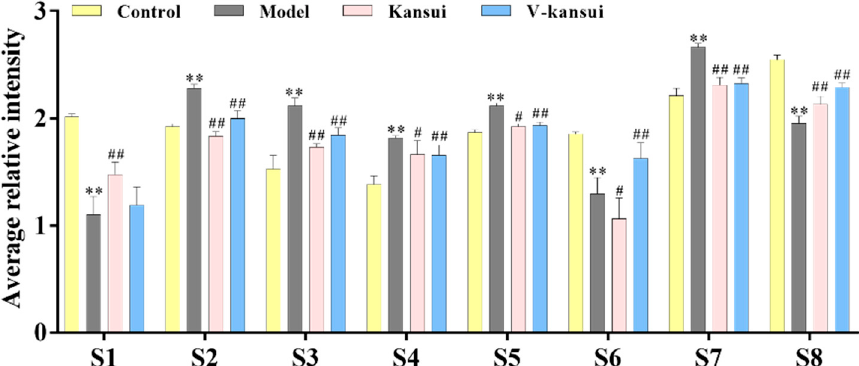
Figure 2. The average relative intensity changes of serum endogenous metabolites from different groups. Comparing the model group with the control group, ** indicates p < 0.01.; Comparing the kansui group and V-kansui group with the model group, # indicates p < 0.05, and ## indicates p < 0.01.